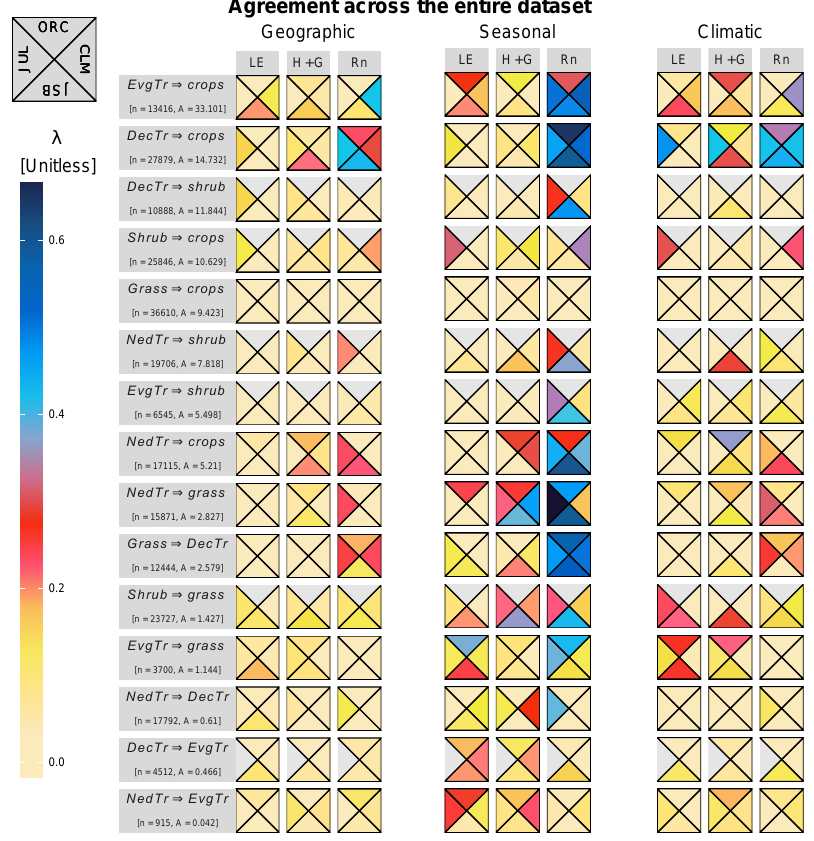
Figure 6. Summary of the agreement between models and remote sensing for all fluxes and all transitions in each of three facets of analysis: spatial, seasonal and climatic. The position of each triangle represents one of the four land surface models as shown in the top corner: ORCHIDEE (ORC), the Community Land Model (CLM), JSBACH (JSB) and JULES (JUL). The fluxes represented are net radiation (Rn), latent heat flux (LE), and the combination of the sensible and ground heat fluxes (H + G). The colour of the triangle represents the value of the index of agreement λ . Below each transition label, the number n provides the total number of original individual spatio-temporal records used to calculate each metric. The order of the transitions (from top to bottom) corresponds to the order of gross changes that have occurred between 2000 and 2015 according the ESA CCI land cover maps, which is provided below each transition label in megahectares